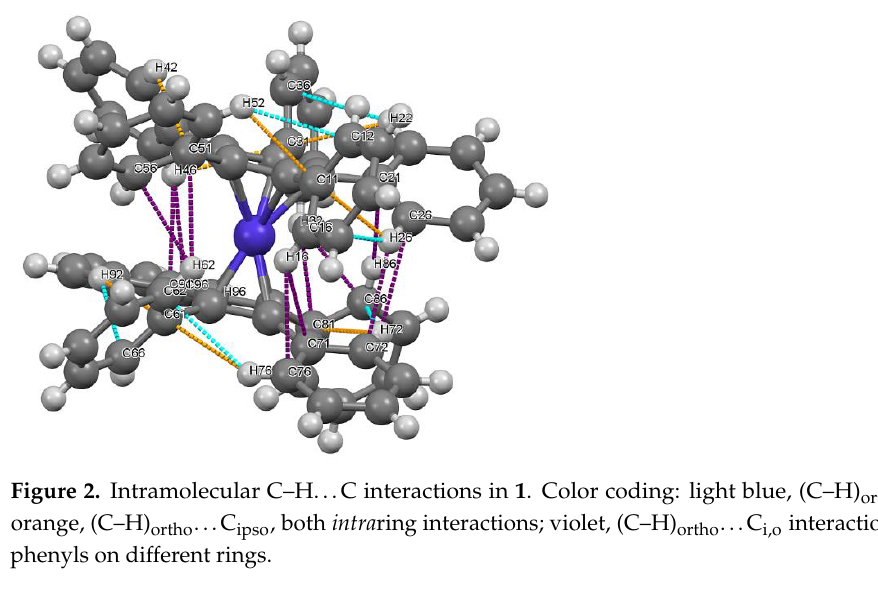
Figure 2. Intramolecular C –H…C interactions in 1 . Color coding: light blue, (C – H) ortho …C ortho ; or- ange, (C – H) ortho …C ipso , both intra ring interactions; violet, (C – H) ortho …C i,o interactions between phenyls on different rings.